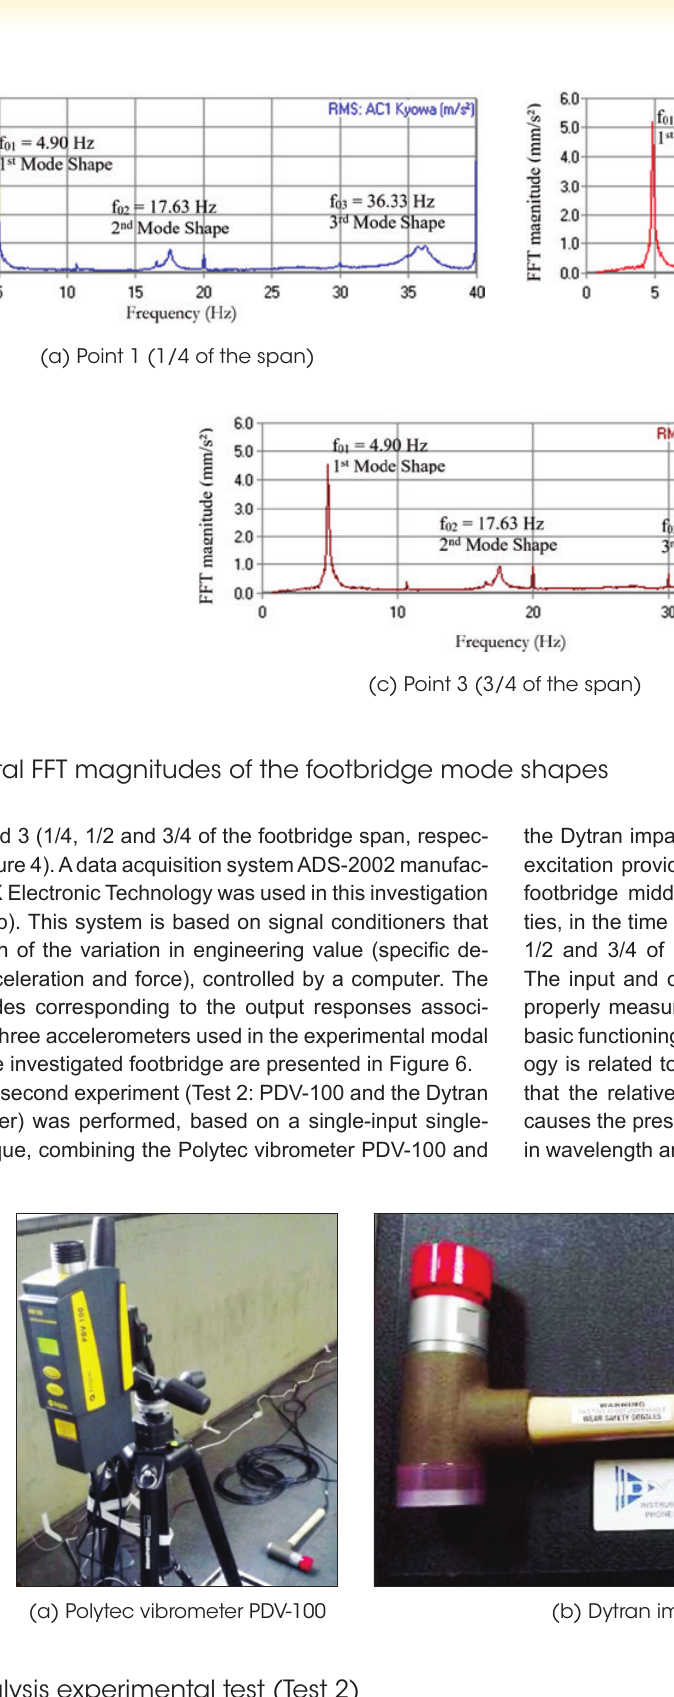
Modal analysis experimental test (Test